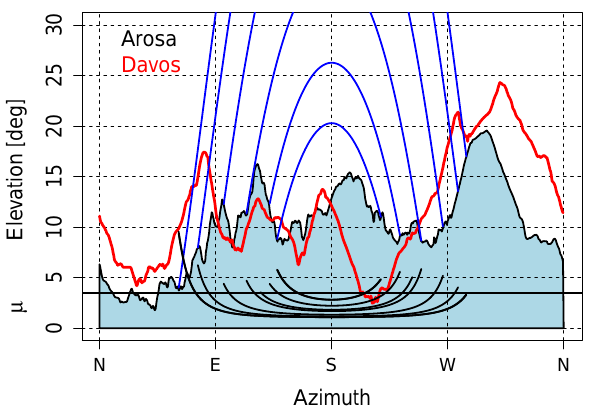
Figure 2. Calculated horizon from the Arosa (blue shaded) and Davos (red line) sites. The blue lines refer to the course of the sun at the beginning of the month from January to June. The black lines are the corresponding air mass µ daily cycle for the different sun elevation